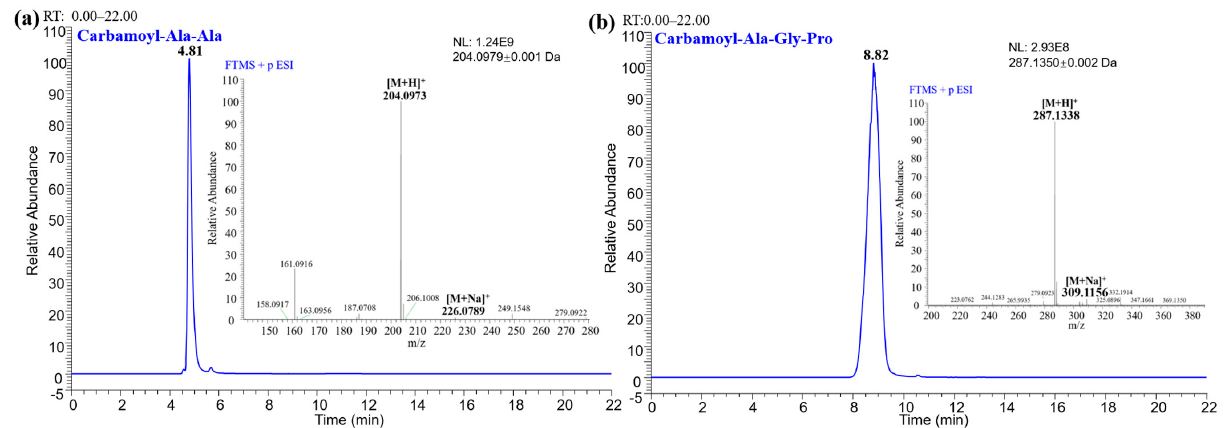
Figure 5. Derivatization of Peptides. ( a ) EIC-MS profile of carbamoyl-Ala-Ala. ( b ) EIC-MS profile of carbamoyl-Ala-Gly-Pro.